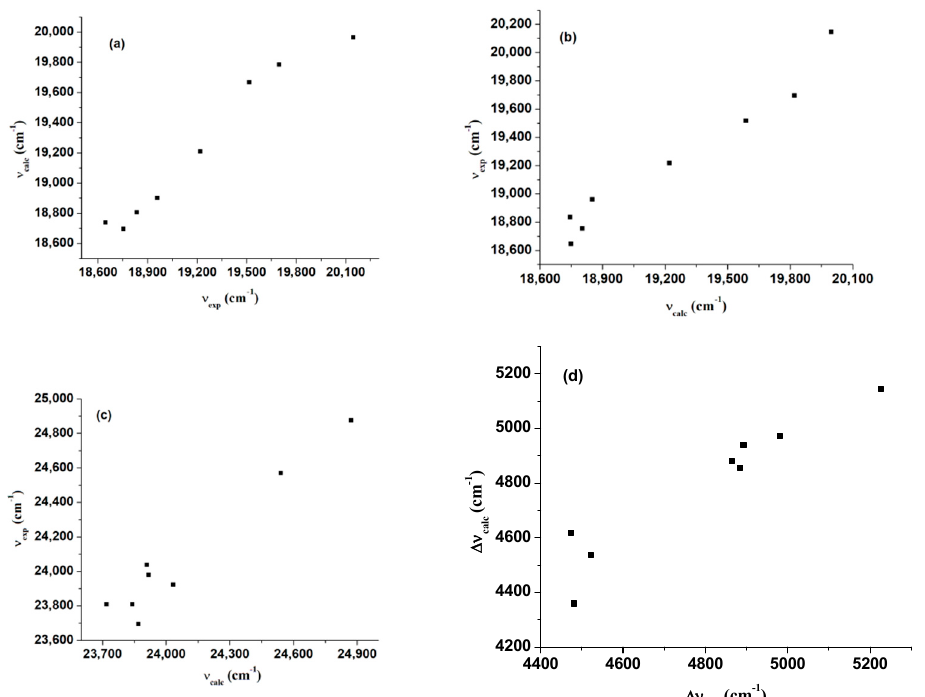
Figure 5. Linear relationship between the experimental maxima and ( a ) predicted fluorescence maxima using multilinear regression with [f(n), f( ε ), β , α ] scale for 7 , ( b ) fluorescence frequencies estimated using Catalan parameters for 8 , ( c ) calculated ν a of 7 using Kamlet–Taft scale, and ( d ) predicted Δ ν using [f(n), f( ε ), β , α ] scale for 7 .